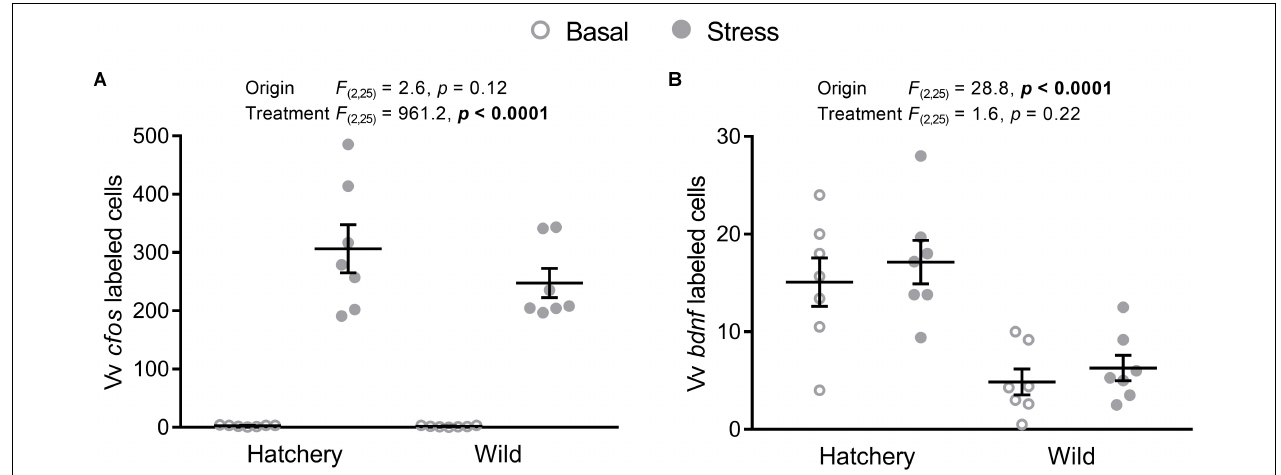
FIGURE 5 | In situ hybridization labeled cfos and bdnf cells in the Vv. Effect of origin (hatchery vs. wild) and treatment (basal vs. stress) on mean ± SEM expression of cfos (A) and brain-derived neurotrophic factor ( bdnf ; B ) in the ventral part of the ventral telencephalon (Vv). Two-way analysis of variance (ANOVA) statistics are displayed in each panel, n = 7 per treatment.